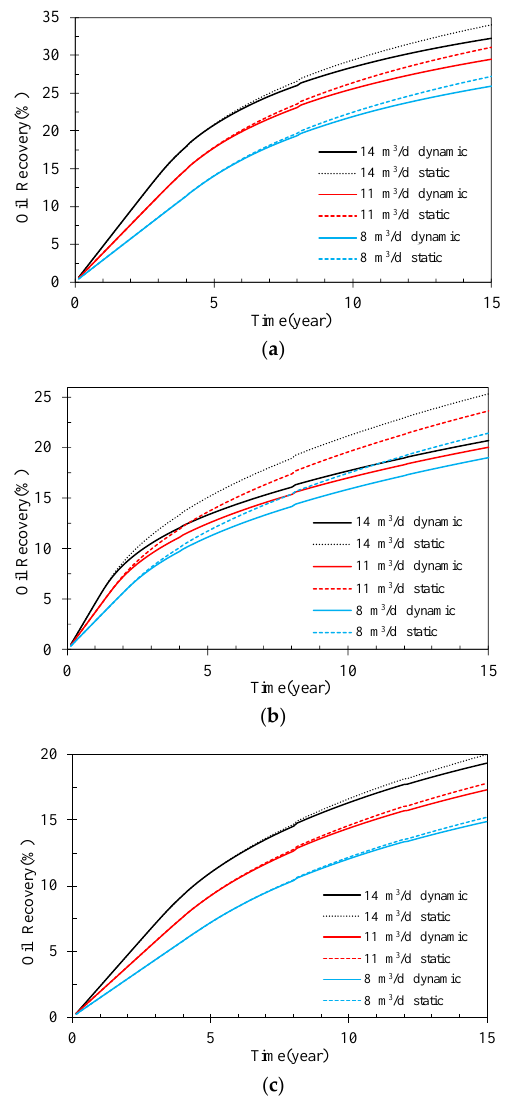
Figure 9. Comparison of oil recovery curves at different production rates of three types of geological reservoirs. ( a ) Oil recovery under different development strategies in the homogeneous reservoir.